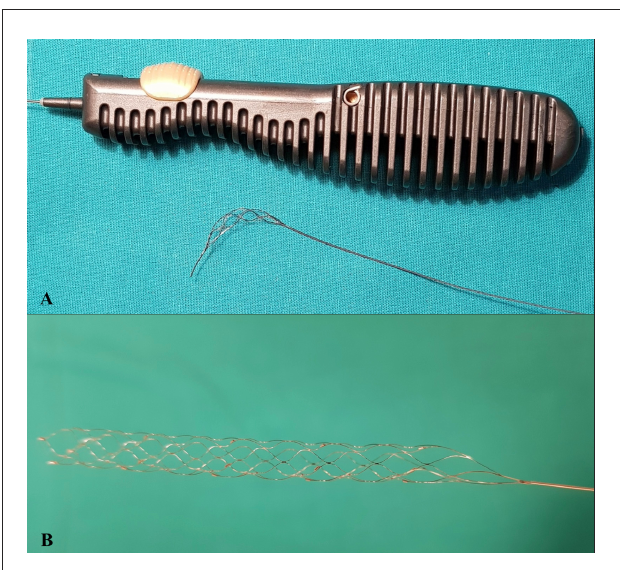
FIGURE1 Intraoperative images of SRs during mechanical thrombectomy. (A) Tigertriever 17 (Rapid-medical); (B) Solitaire × 4 × 40mm (Medtronic); (C) pRESET 4x20mm (Phenox).